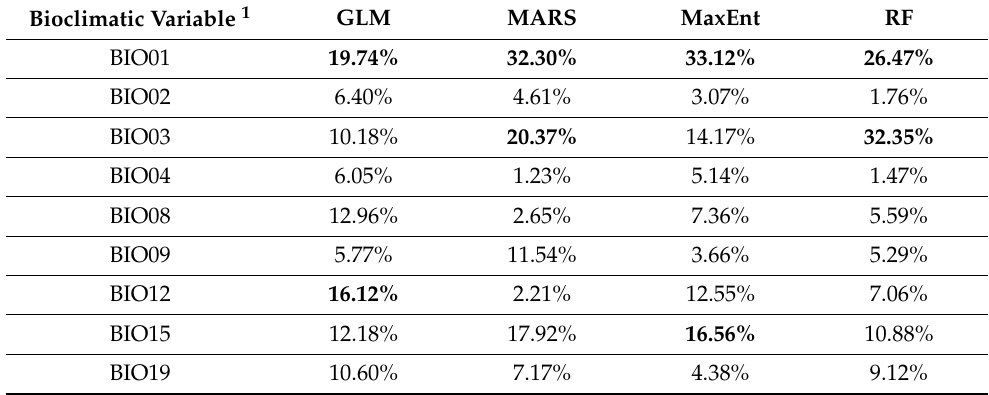
Table 2. Relative contribution of each bioclimatic variable to Generalized Linear Model (GLM), Multivariate Adaptive Regression Splines (MARS) model, MaxEnt model, and Random Forest (RF) model to estimate the suitability of Italy for Toumeyella parvicornis